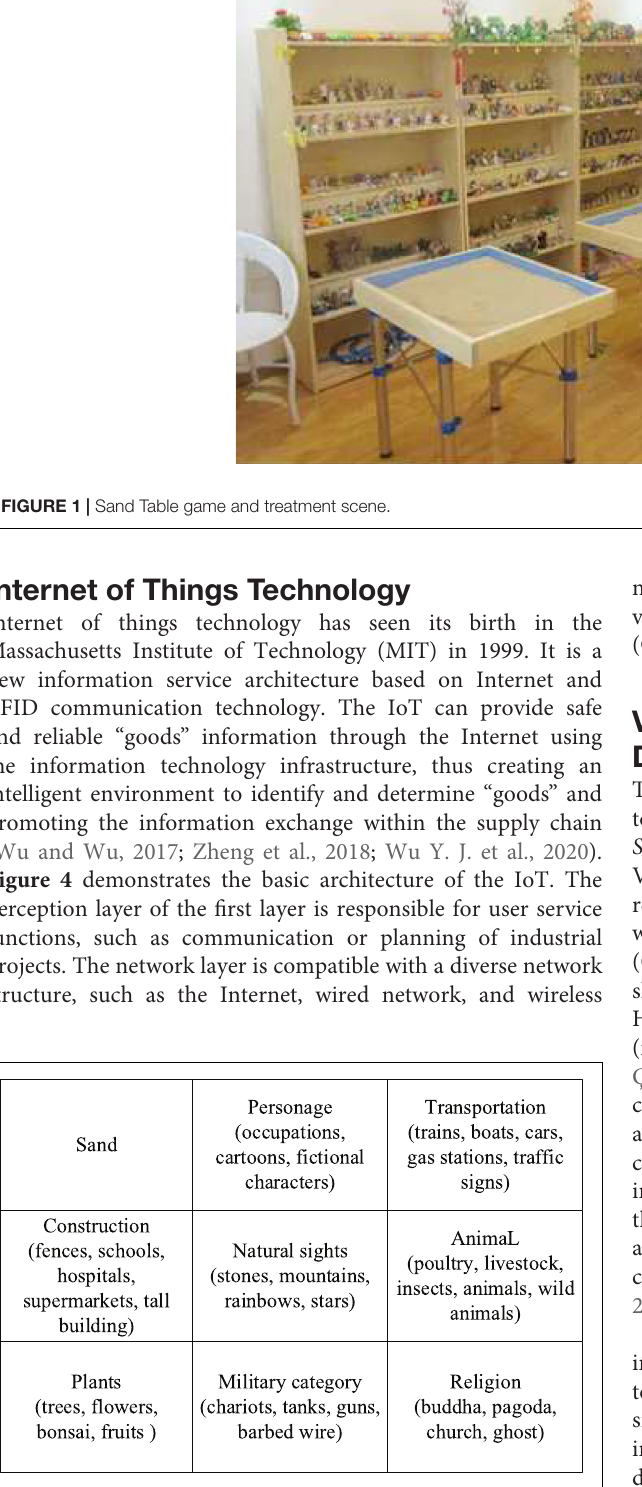
FIGURE 2 | Sand Table game mold and essential